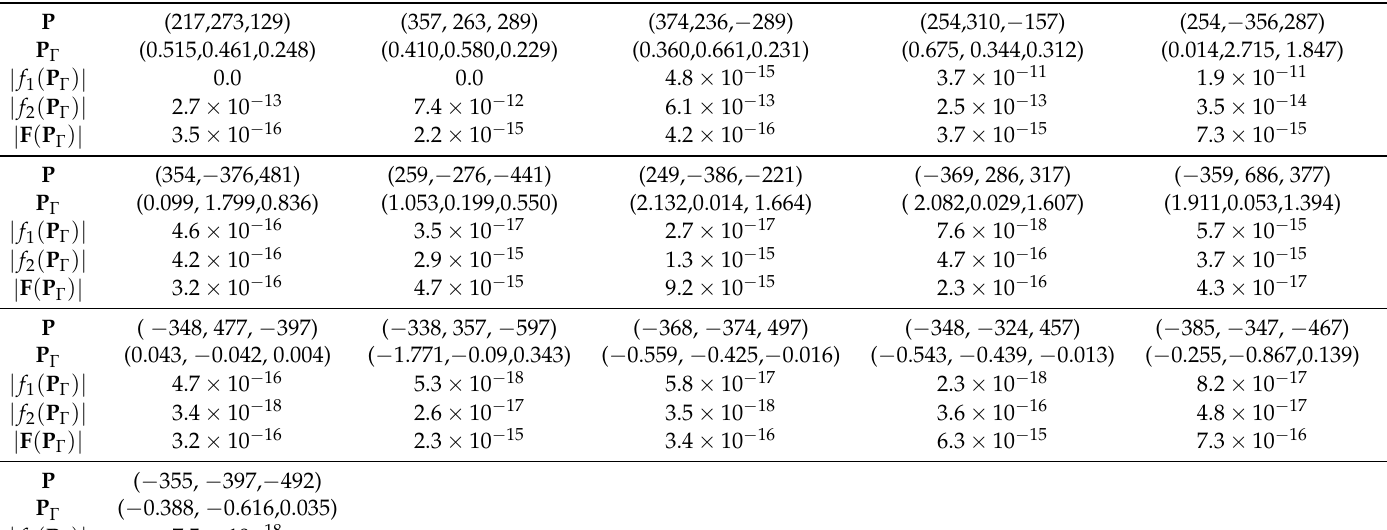
Table 2. Test results of Algorithm 4 for Example